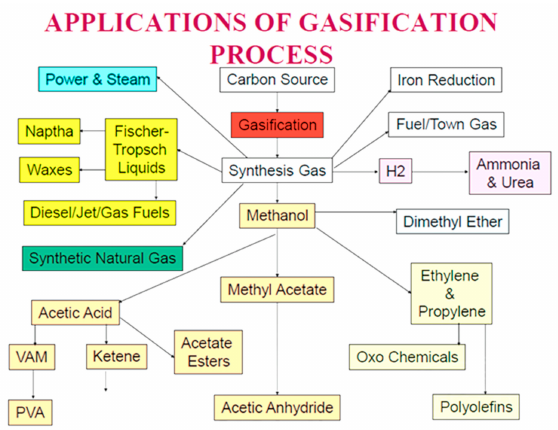
Figure 1. Multitude applications of syngas (Sengupta, 2020) (reproduced with